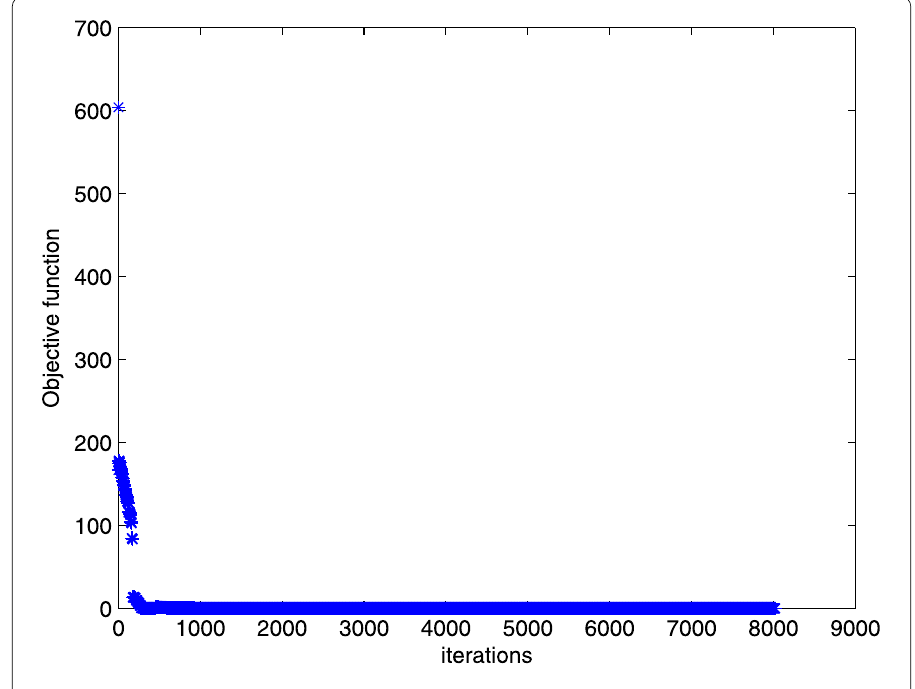
Figure 3 Numerical results for solving Example 2 with Algorithm 1